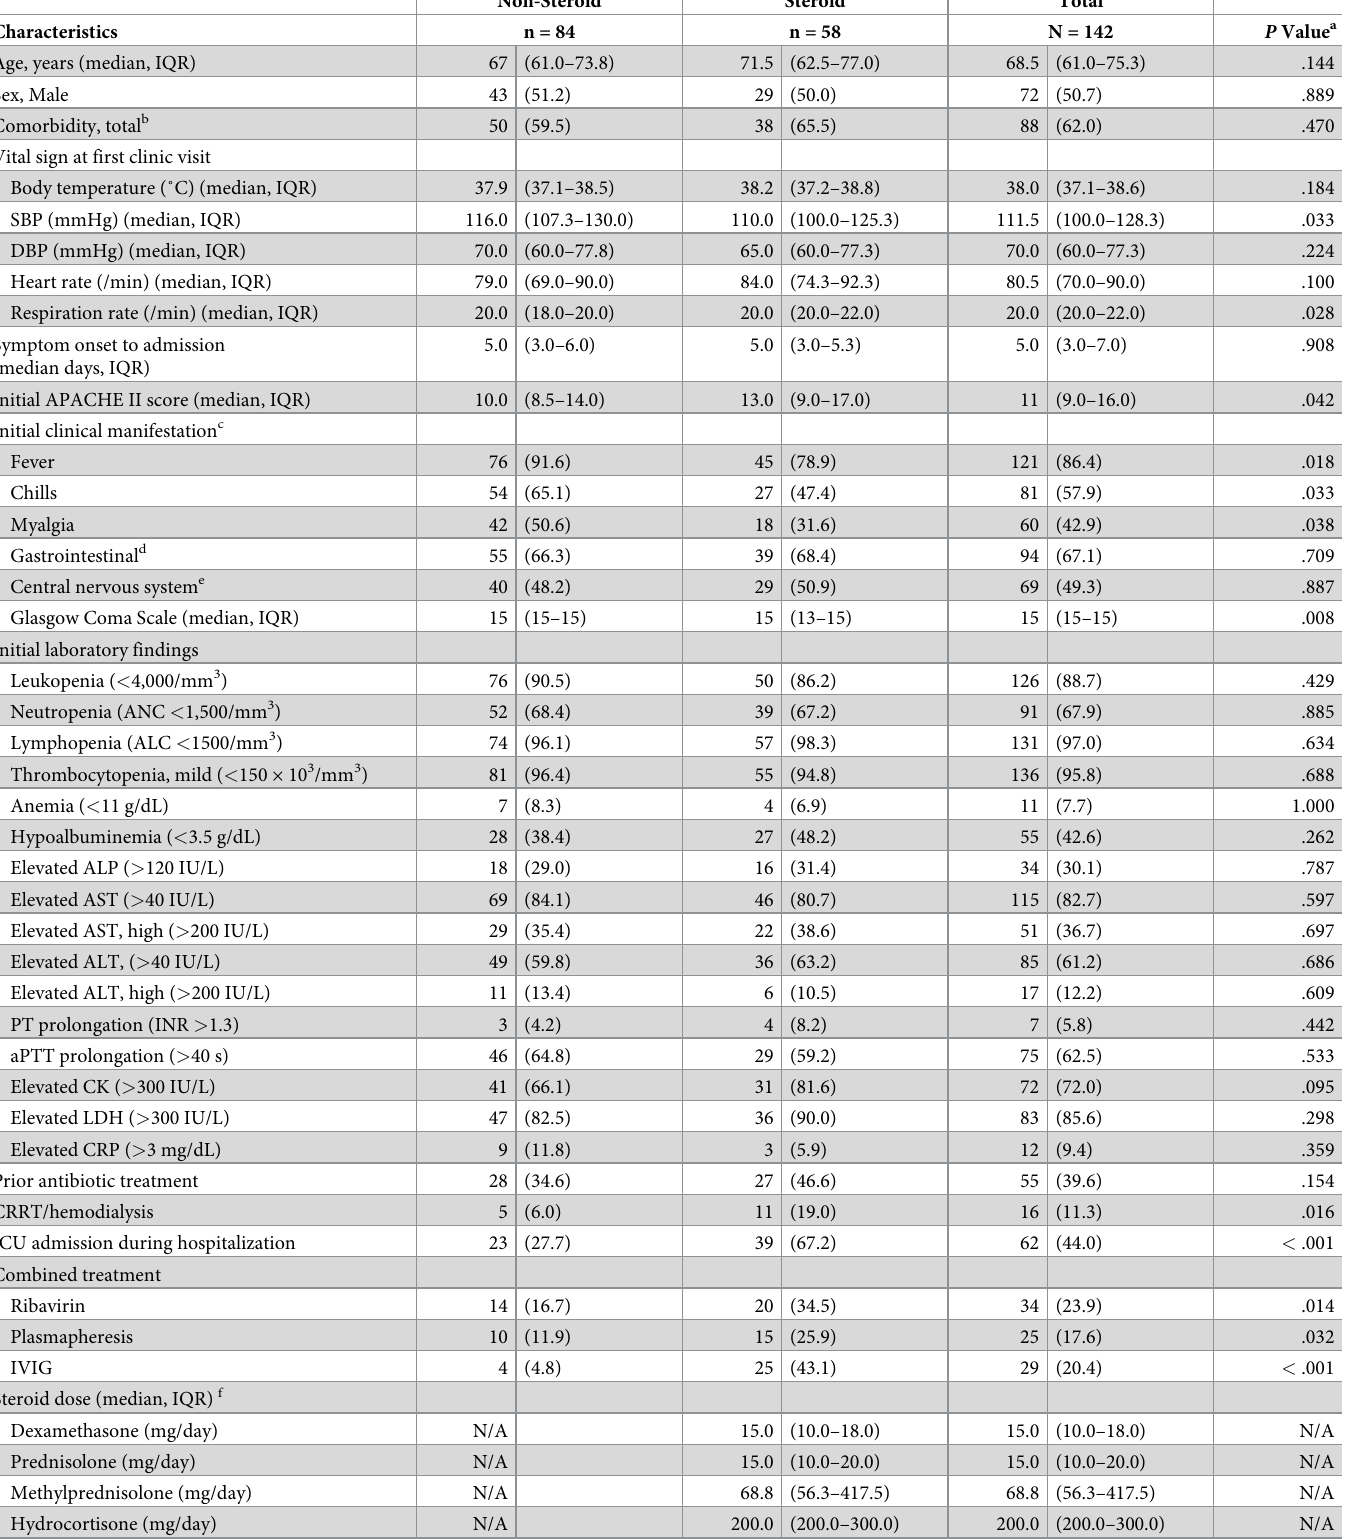
Table 2. General, Clinical Characteristics, and Laboratory Results of Patients with SFTS in the Steroid and Non-Steroid Groups